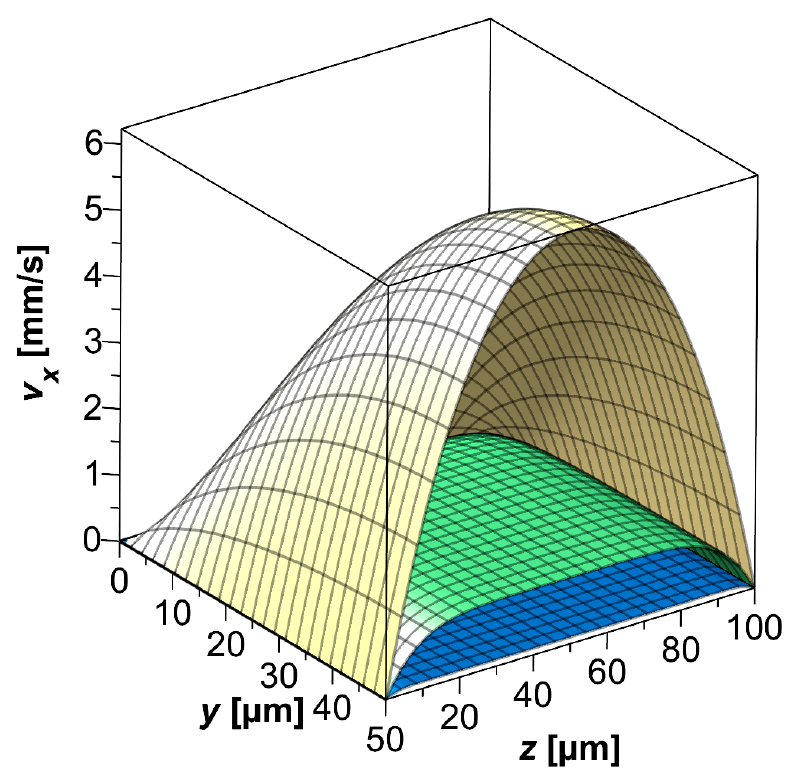
Figure 2. Velocity profile calculated from the analytical solution of Equation (30) for water as fluid and a channel with 100 µ m width and 100 µ m height. The Fourier series is expanded to n max = m max = 10. The expansion order of the Fourier series was 10 both along y and z . Velocity profiles for di ff erent points in time are plotted: 10 µ s (dark blue), 100 µ s (medium green) and 1000 µ s (light yellow).